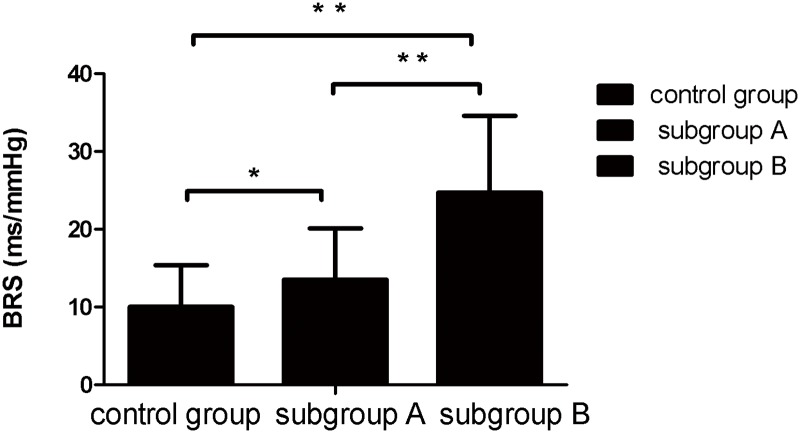
BRS among children in subgroup A and B, and controls.Compared with that of control group, BRS was increased in subgroups A and B (P <0.05, P <0.01, respectively). BRS of subgroup B was higher than that of subgroup A (24.7±9.9 ms/mmHg vs 13.5±6.6 ms/mmHg, P <0.01).